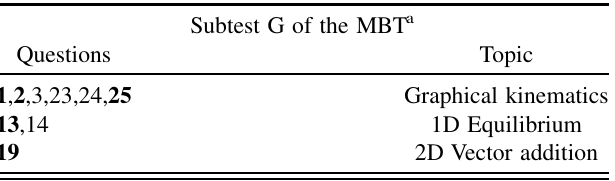
TABLE VI. The MBT questions assigned to subtest G. Five of these questions (in bold) showed evidence of improvement by the seniors relative to their freshman posttest scores. The other four are directly related to the questions exhibiting gain, and each has a correct response rate above 79% on all three administrations of the MBT (freshman pretest, freshman postt- est, and senior retest). Full question-by-question data are given in Table